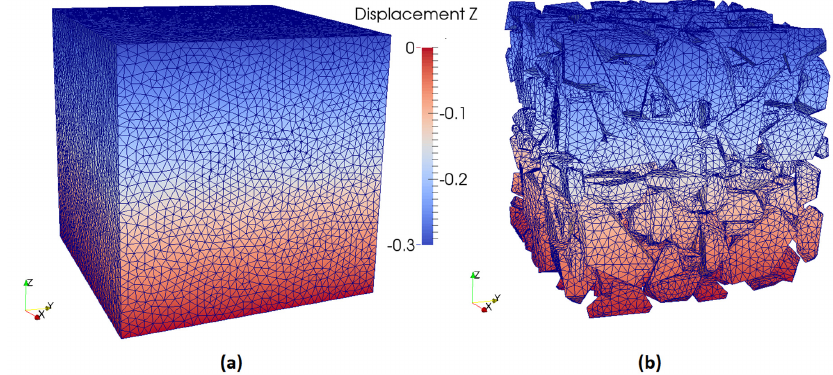
Figure 4. Case #4 simulation; 8-blocks mesh. ( a ) mesh view; ( b ) view of aggregate elements